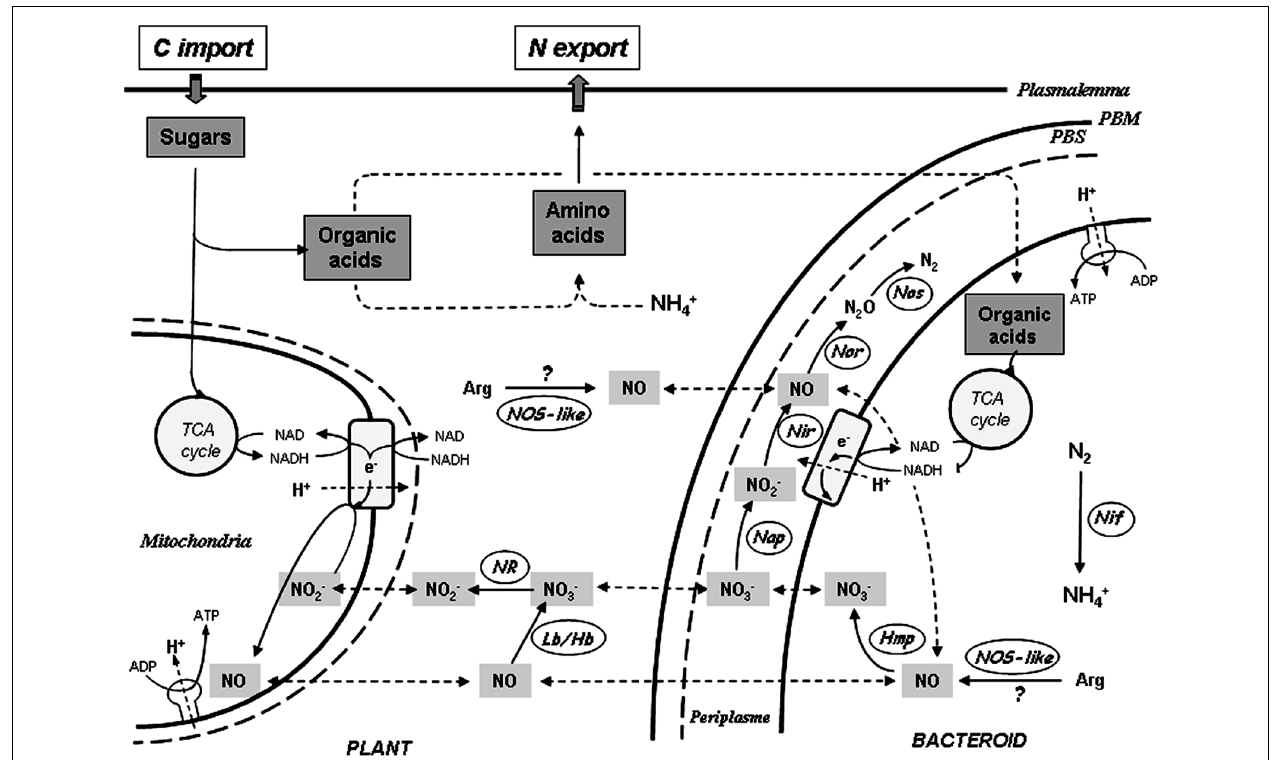
FIGURE 1 | Schematic representation of NO sources in nitrogen-fixing nodules. On the plant side, NO is produced through the cyclic nitrate–NO respiration pathway involving nitrate reductase (NR), mitochondrial electron transfer chain (ETC) and hemoglobin (Lb/Hb). The production of NO via a plant NO synthase-like enzyme (NOS-like) is hypothetical. On the bacteroid side, NO is produced as an intermediate of the denitrification pathway involving nitrate reductase (Nap), nitrite reductase (Nir), NO reductase (Nor),